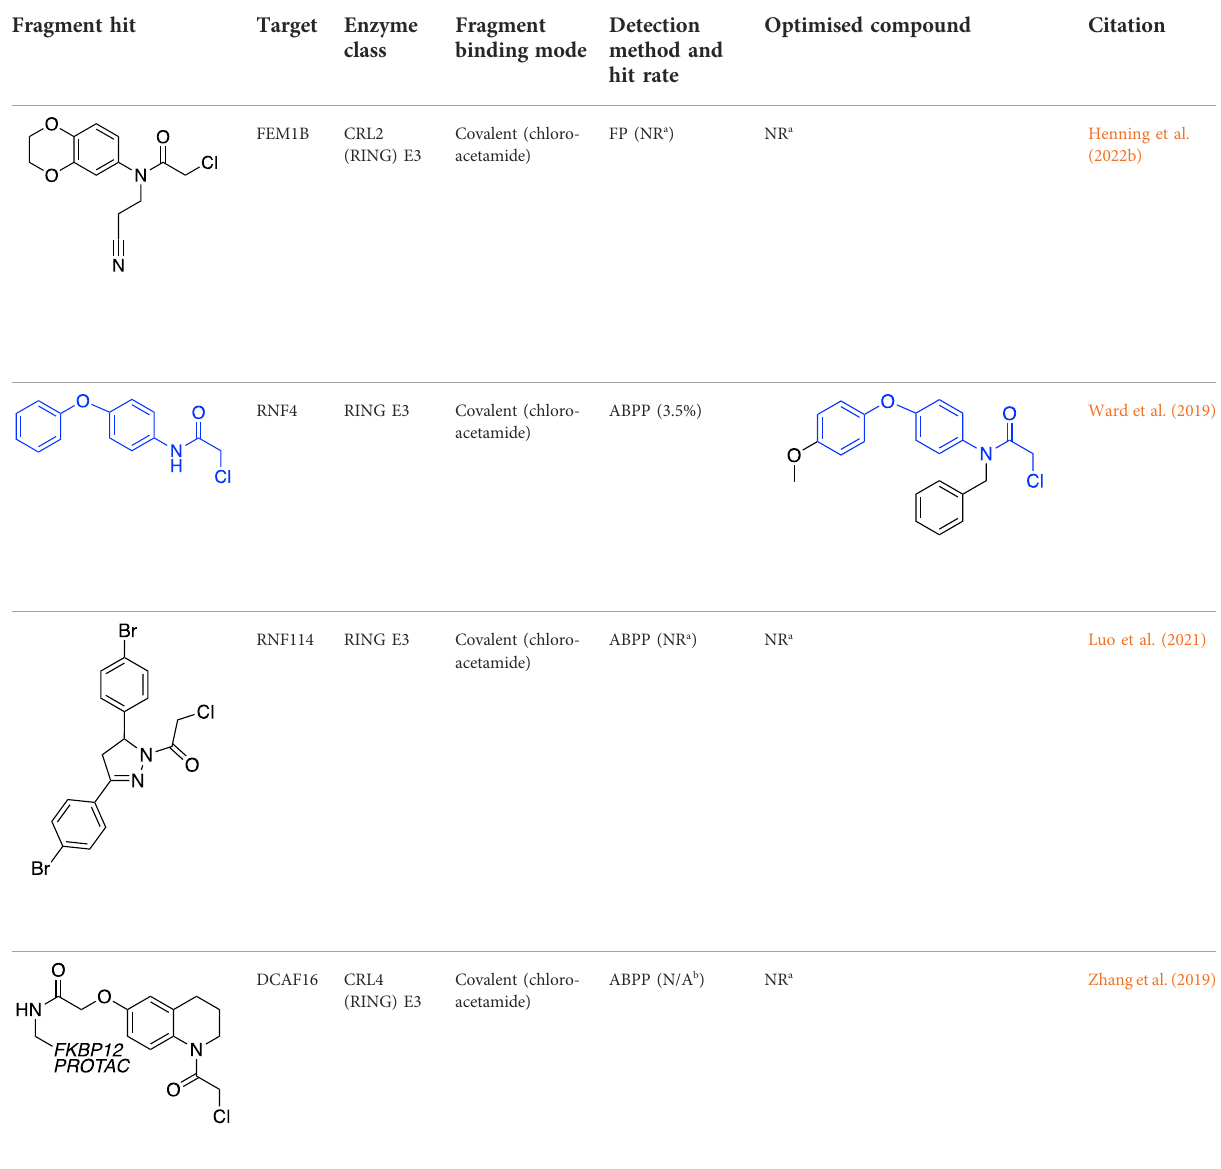
TABLE 1 ( Continued ) Summary of fragment hits and fragment-derived modulators of ubiquitin system proteins. Pharmacophores from original fragment hits which were retained in optimised compounds are highlighted in blue/green/purple. Potency/binding af fi nity of optimised compounds was de fi ned individually in each report (see